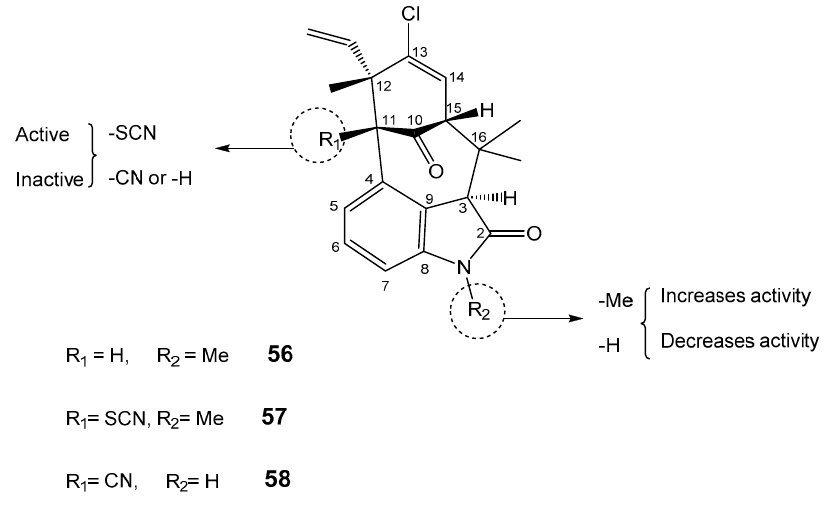
Figure 10. Structures of welwitindolinones 56 – 58 and SAR studies. The dashed circle indicates the groups important for P-gp.